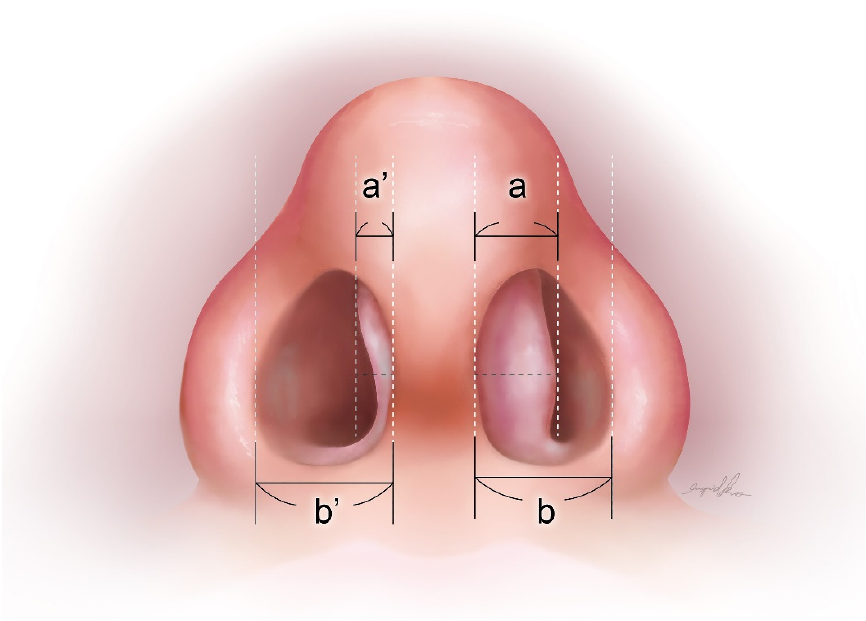
Figure 3. Illustration of calculation of visual analog scale (VAS).